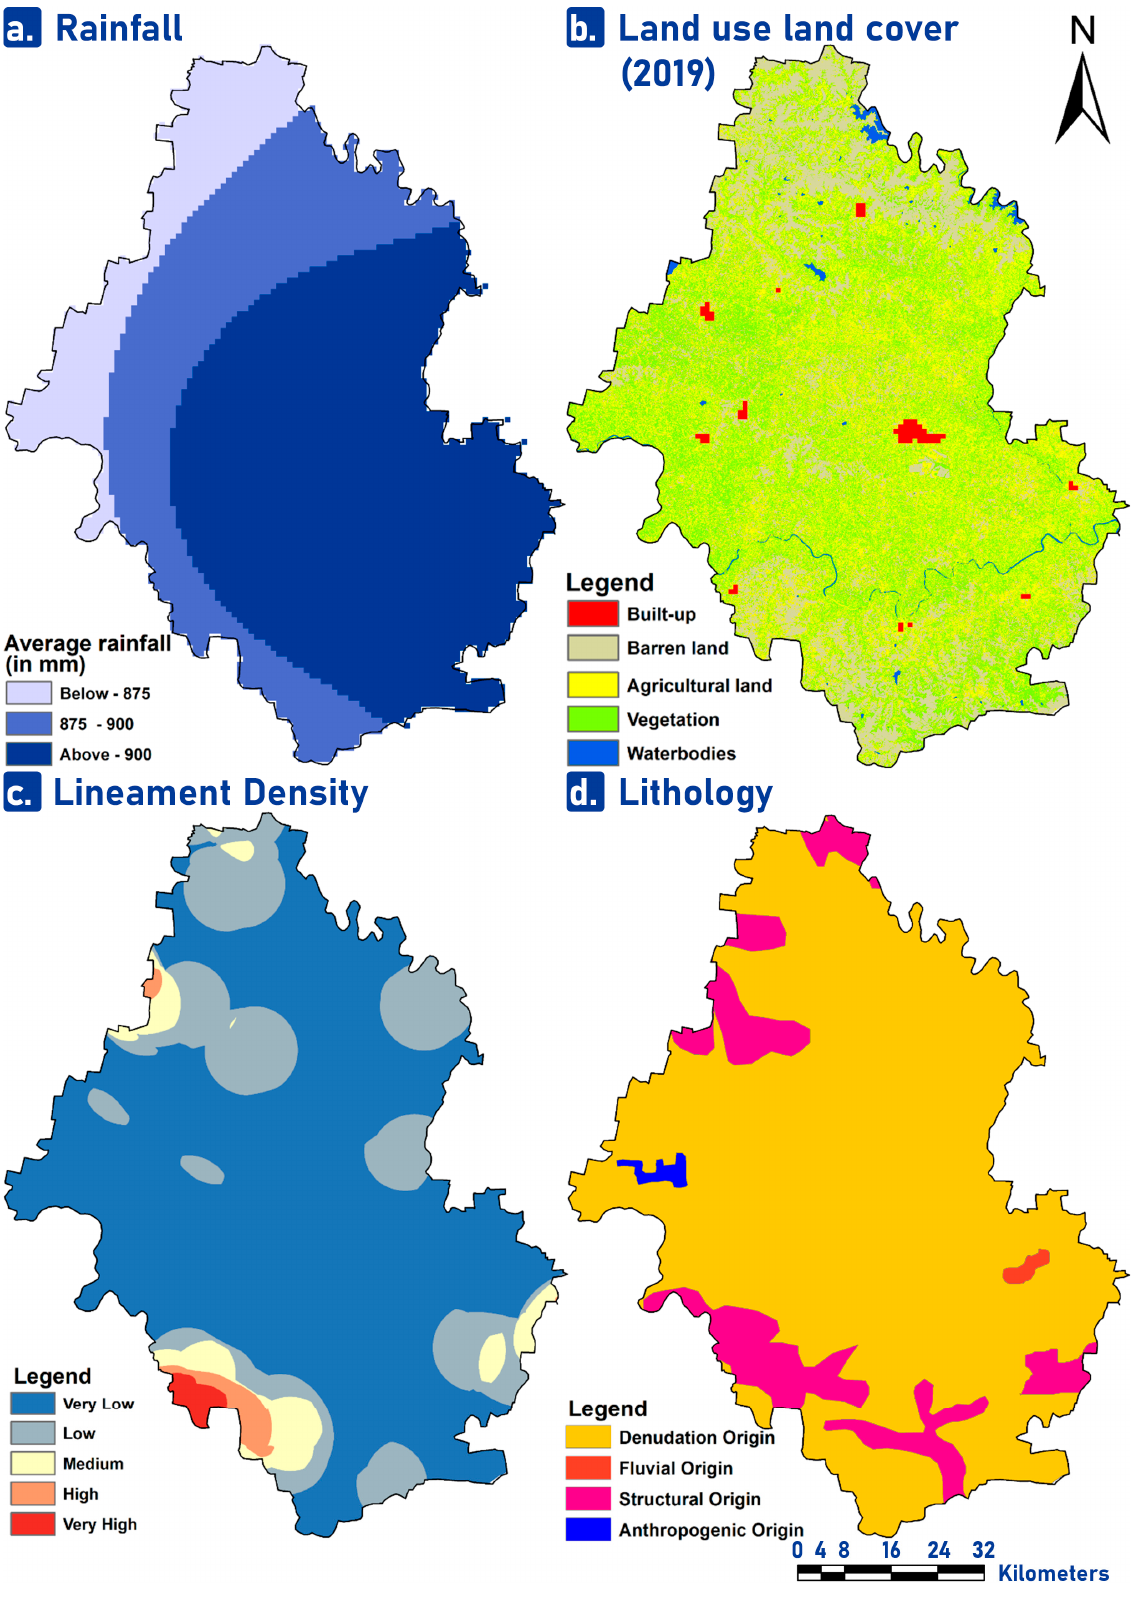
Figure 3. Factors affecting groundwater potential: ( a ) rainfall, ( b ) land use land cover, ( c ) lineament density, (d) lithology.